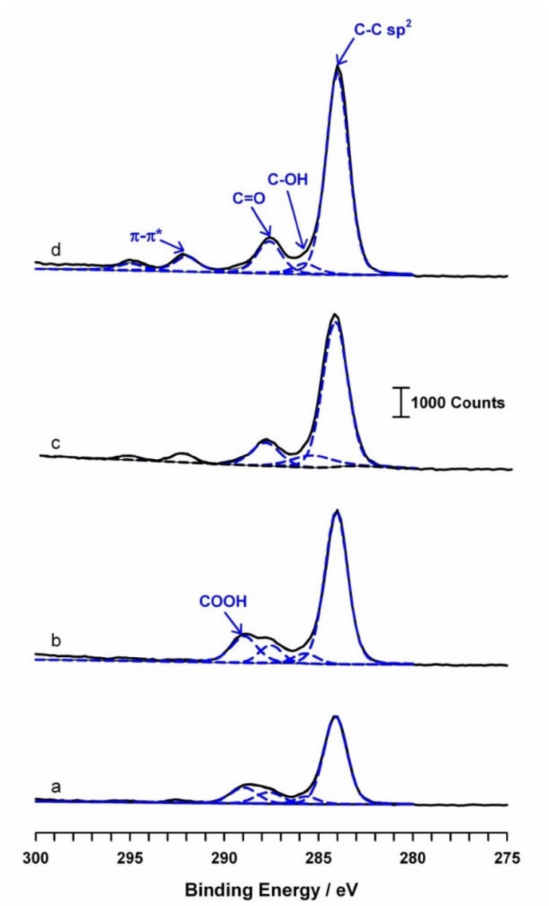
Figure 9. The XPS spectrum of the exfoliated carbon nanoparticles attained through electro-exfoliated at 2.0 V versus Ag/AgCl in 0.01 M NaOH + 0.1 M PO 4 3 − solutions at ( a ) 0 ◦ C, ( b ) 20 ◦ C, ( c ) 30 ◦ C, and ( d ) 40 ◦